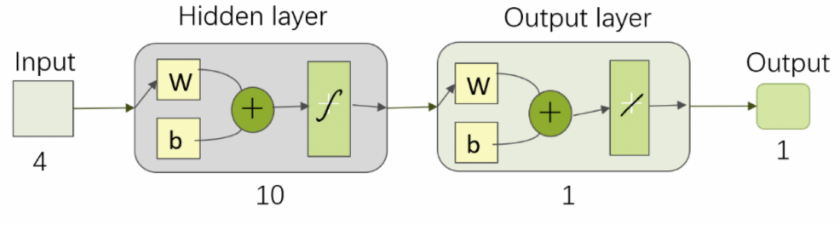
Figure 2. Conceptual diagram of the model used. (w: weight, b: bias).